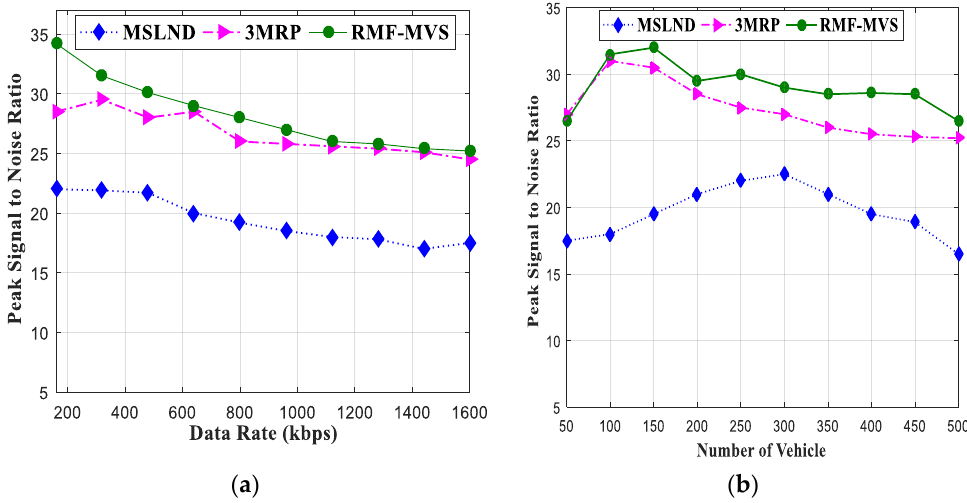
Figure 6. Signal to Noise Ratio (PSNR) Results Based on Different ( a ) Number of Vehicles and ( b ) Data Rates.